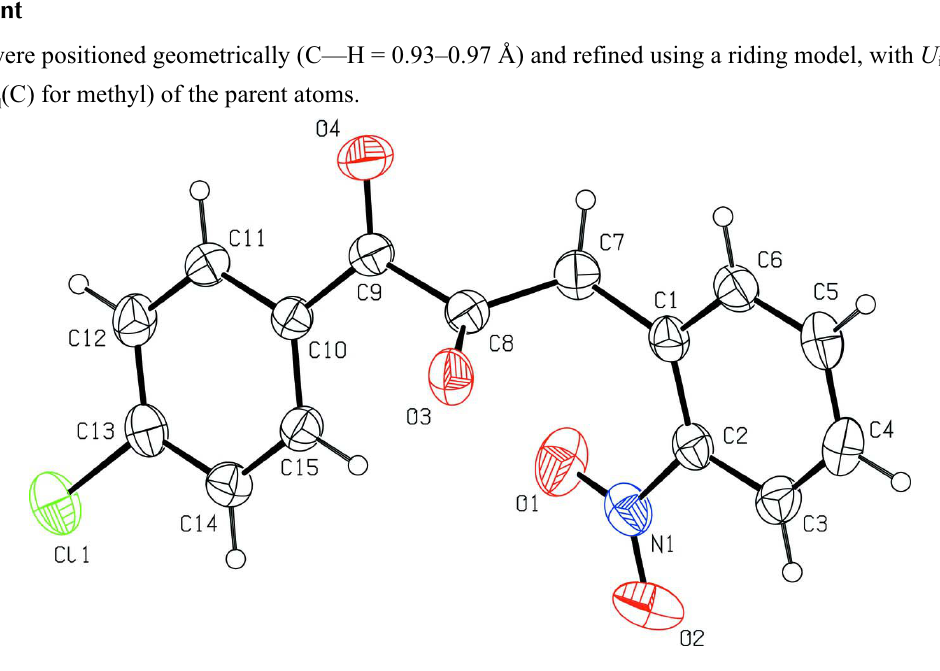
View of the title molecule showing the atom-labelling scheme. Displacement ellipsoids are drawn at the 30% probability level. H atoms are represented by spheres of arbitrary